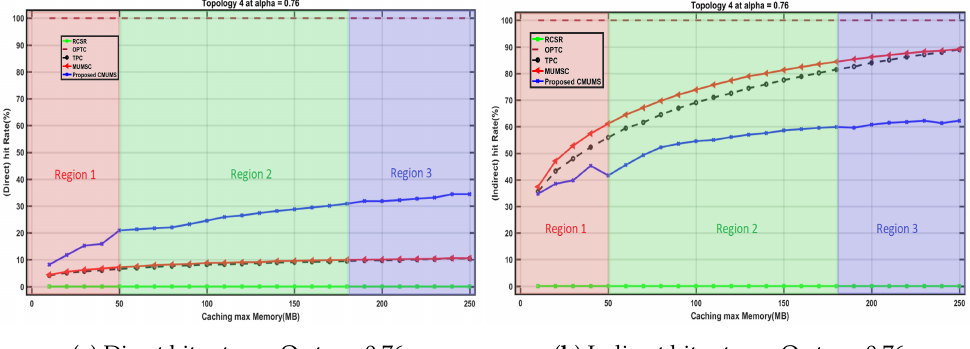
Figure 11. Direct and Indirect hit rate behavior vs. Q.